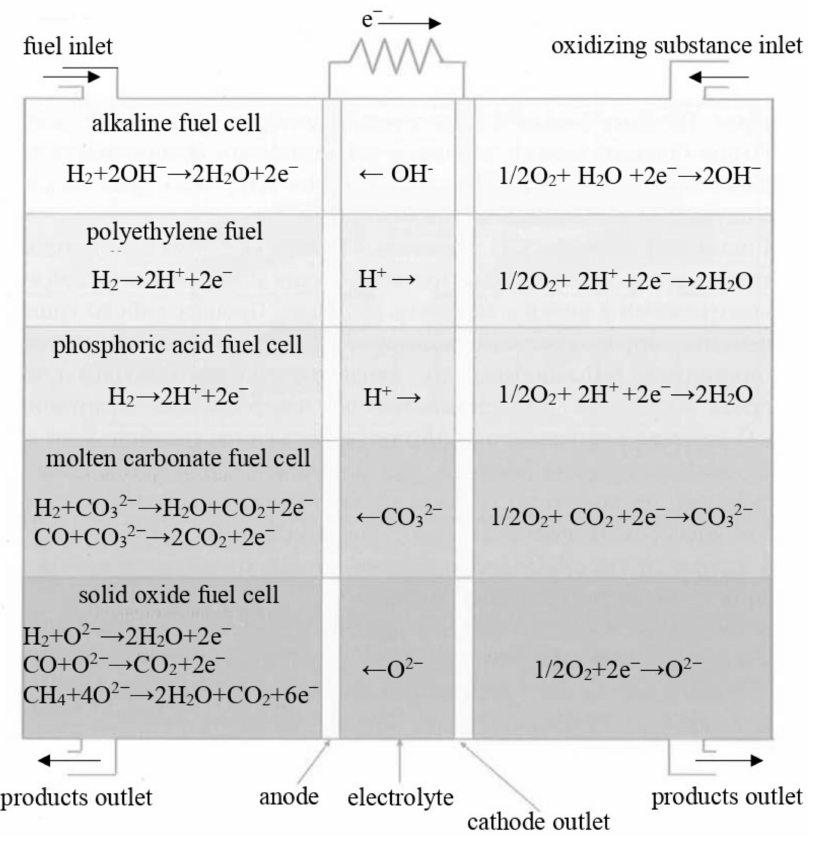
Figure 4. Main processes in fuel cells of various types